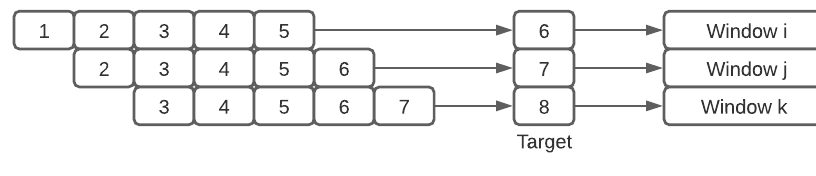
Figure 6. Sliding window.